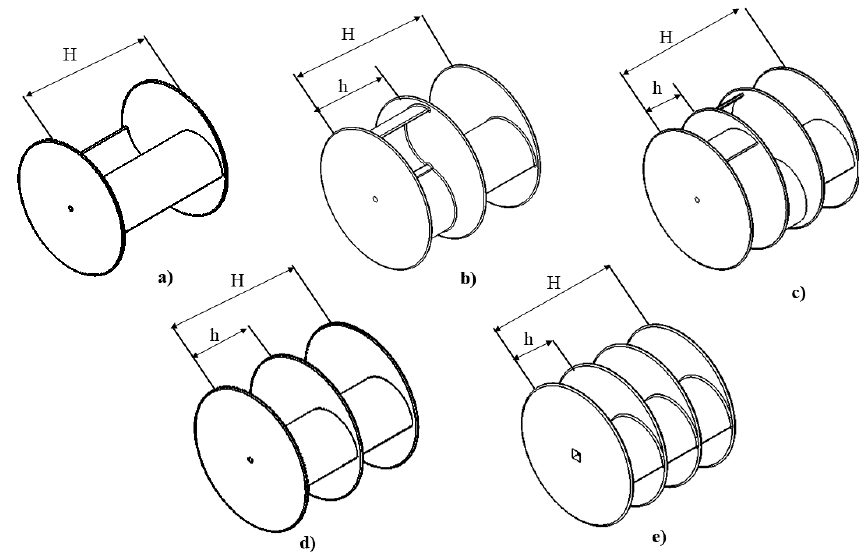
Figure 1: The geometry of a) Single-stage, b) two-stage 90 ∘ , c) three-stage 120 ∘ , d) two-stage 0 ∘ , and e) three-stage 0 ∘